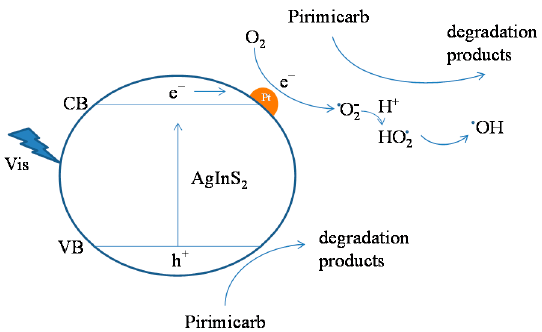
Figure 12. Schematic illustration of the photocatalytic mechanism of the Pt/AgInS 2 photocatalyst.